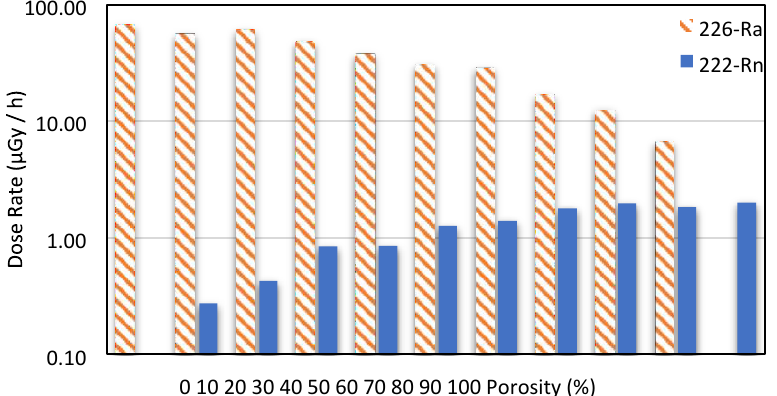
Fig. 3. Dose rate to the diatoms as a function of porosity in the sediments scaled for 30 Bq/gr of 226 Ra and 1000 Bq/L of 222